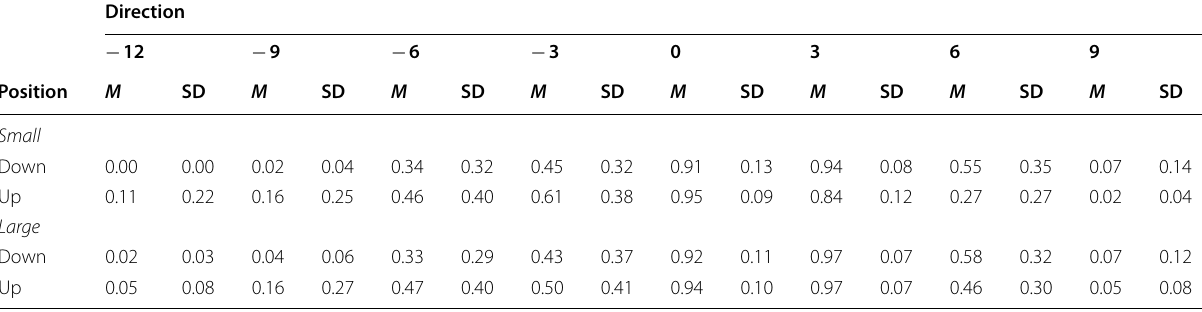
M and SD represent mean and standard deviation,